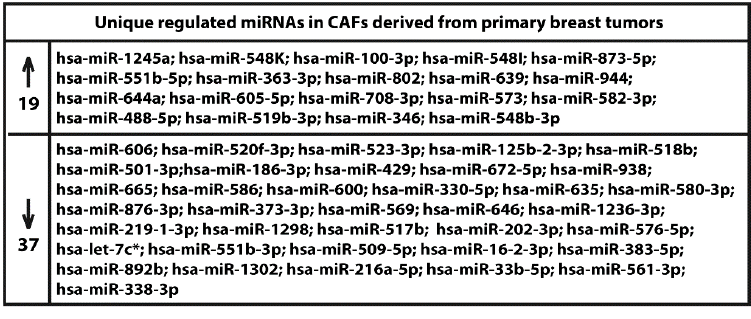
Figure 9. Up and downregulation of unique miRNAs in CAFs derived from primary breast tumors and treated for 4 h with 100 nM E2. Cancers 2019 , 11 , x